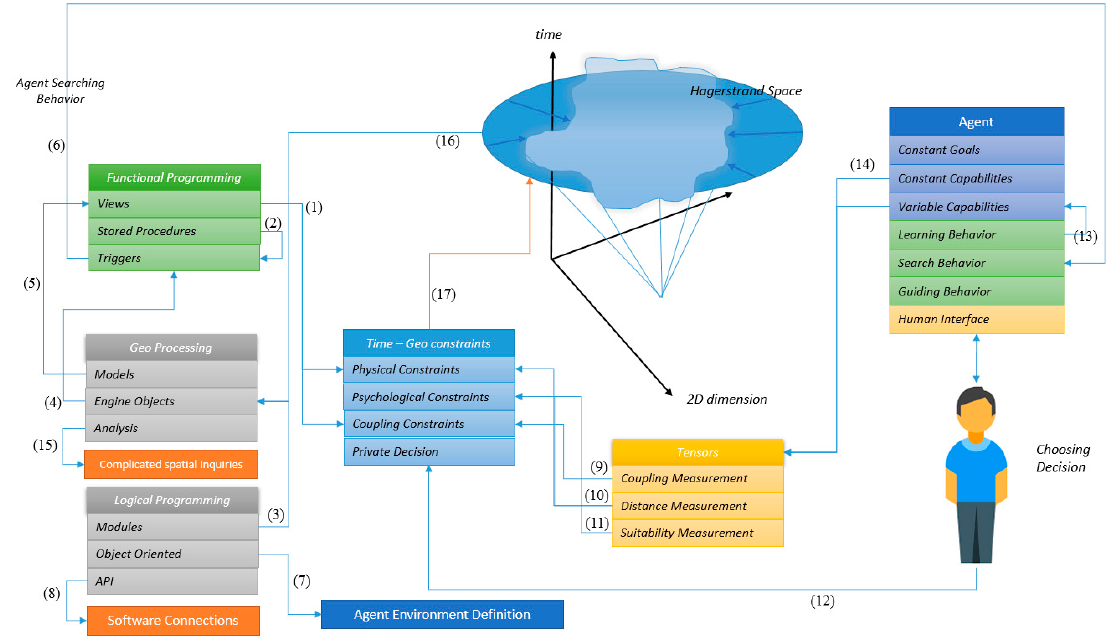
Figure 8. Programming in constructing the agent.